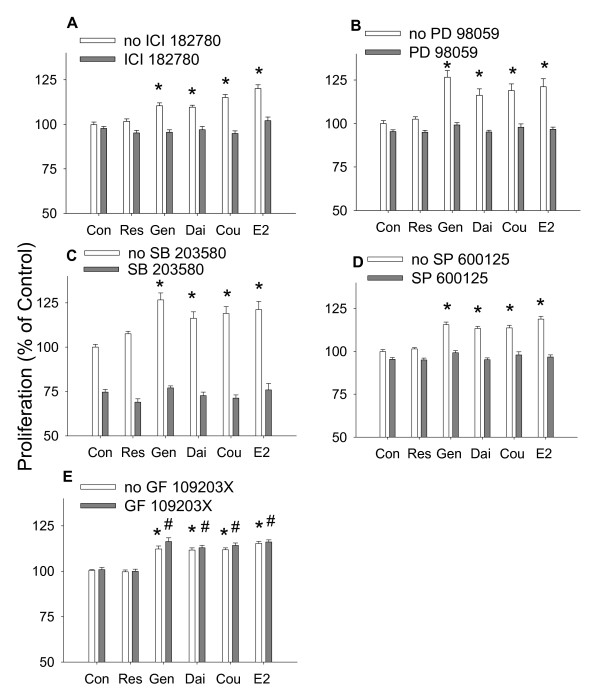
The effects of different antagonists on the proliferative effect of phytoestrogens. The proliferative effects of 10-9 M E2, 10-8 M coumesterol, 10-7 M daidzein, 10-7 M genistein and 10-7 M trans-resveratrol in the presence signaling molecule antagonists for: (A) ERα/β (ICI 182780, 1 nM) (B) ERKs (PD 98059, 10 μM) (C) p38 (SB203580, 1 μM) (D) JNK (SP 600125, 5 μM) (E) PKC (GF 109203×, 10 μM, negative control). * = p < 0.05 compared to control cells treated with vehicle only. # = p < 0.05 compared to cells treated with antagonists only.